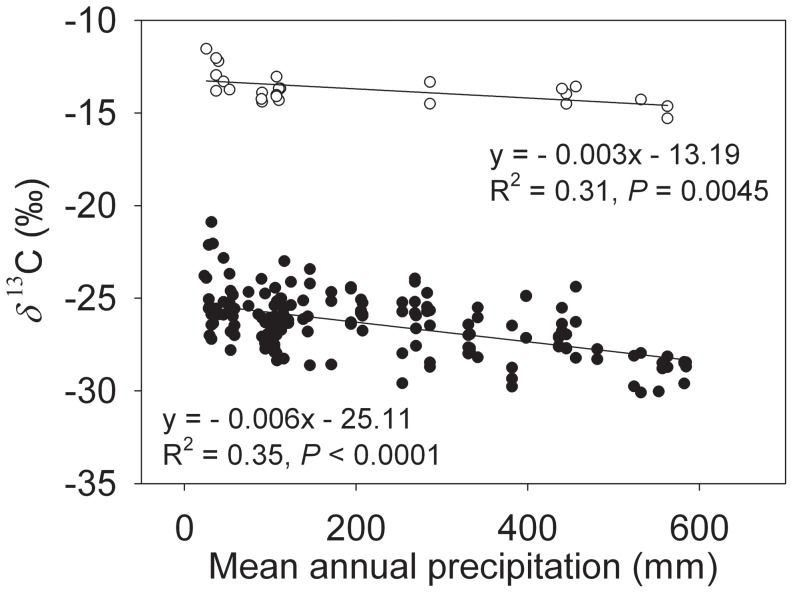
Plant δ
13C values (C3, filled circles; C4, open circles) as a function of mean annual precipitation.Linear regression equations, R
2 and P values are provided.